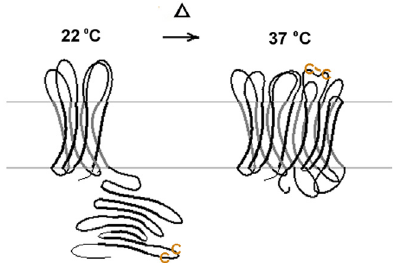
Figure 11. Schematic drawing of the transition from a narrow 8 β -barrel pore at lower temperatures to a large hypothetical 16 β -barrel pore at higher temperatures. From Zakharian and Reusch Biochem 2005